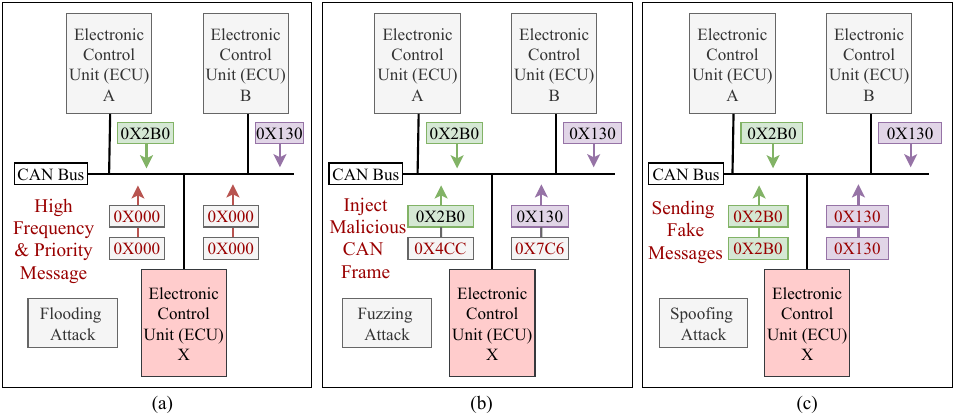
Figure 3. ( a ) Flooding attack scenario against an IVN; ( b ) Fuzzing attack scenario against an IVN; ( c ) Spoofing attack scenario against an